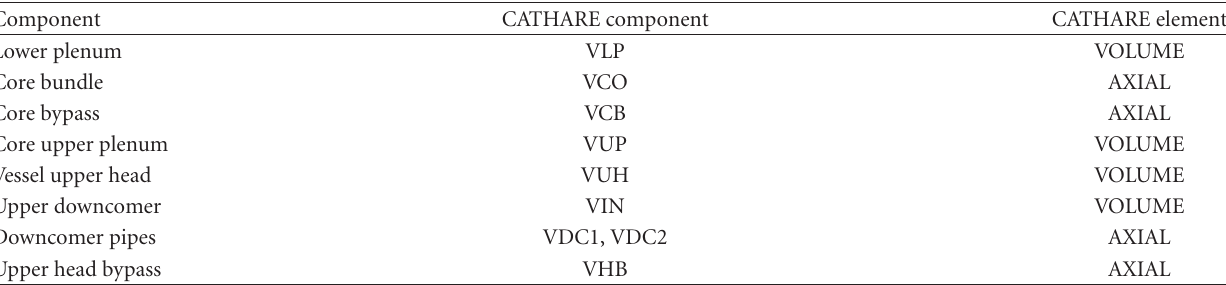
Table 1: Main components of the PKL reactor